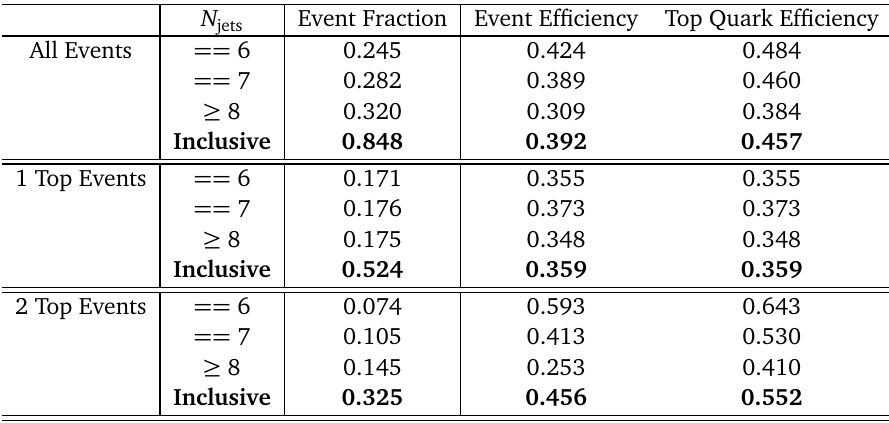
Table 7: χ 2 method results on t ¯ t using Pythia showering.